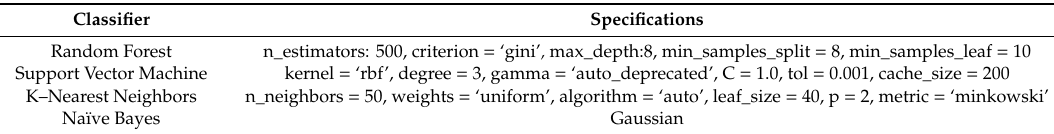
Table 5. State detection: classifiers and